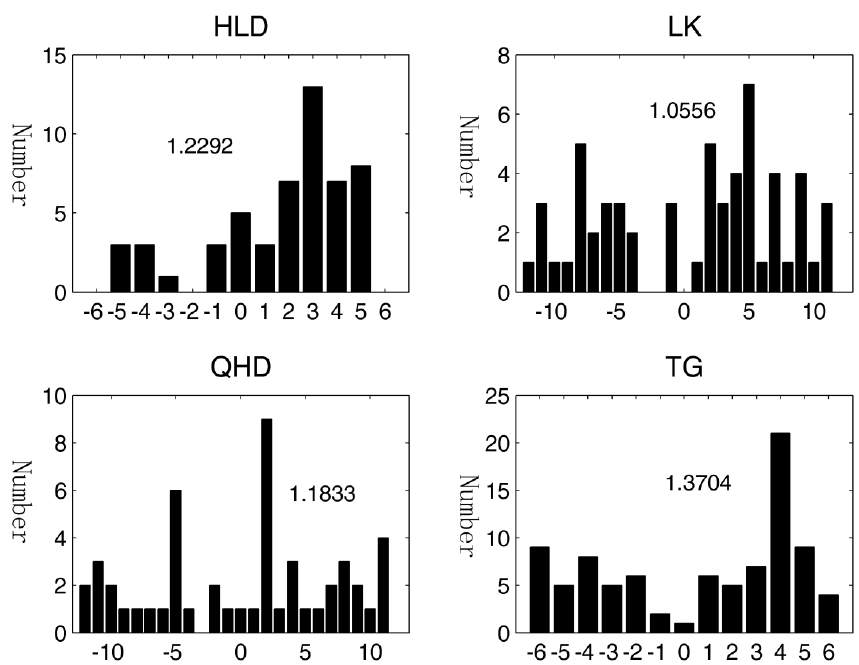
Figure 8. The tide–surge interaction at all four tide gauges, numbers listed in the figure is the value T/ 2 ; y axes are the numbers, and x axes are the hours before and after the high tide.